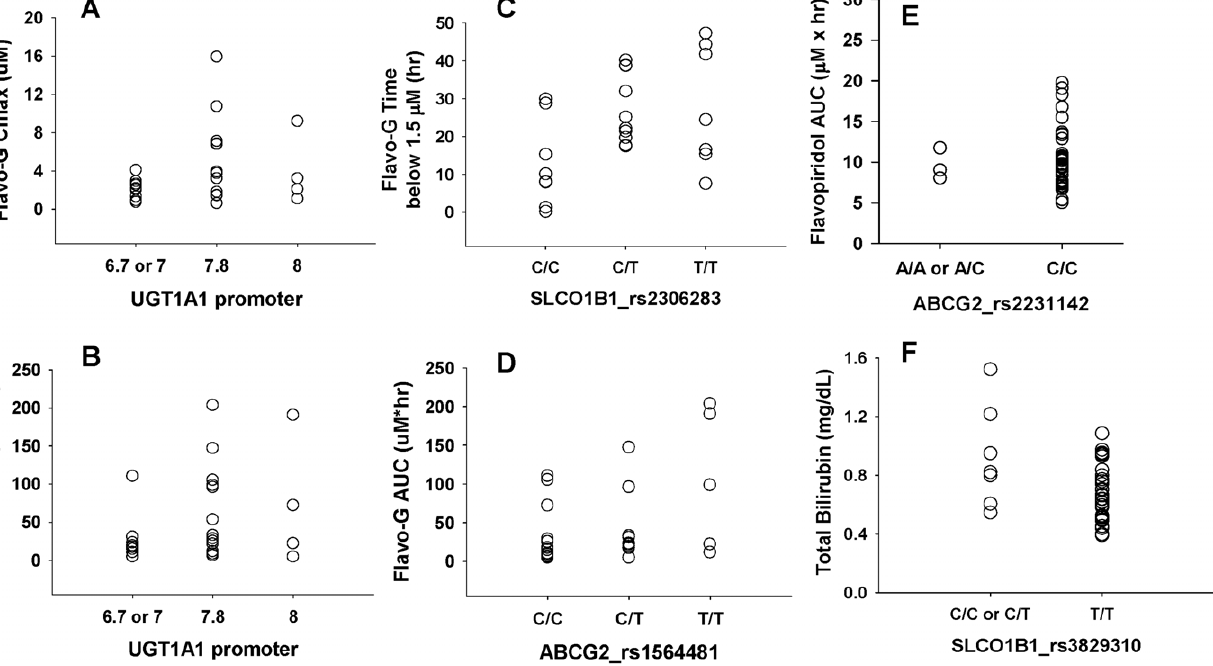
Figure 5. Association of PGx, PK and bilirubin from the phase I dataset. Flavo-G PK parameter estimates from 27 patients were evaluated for relationships with PGx. Fewer TA repeats in the UGT1A1 promoter were weakly associated with lower flavo-G Cmax (Panel A) and AUC (Panel B). For SLCO1B1, the rs2306283 SNP correlated with flavo-G plasma concentrations (the total time flavo-G plasma concentrations were below 1.5 m M, p=.019; Panel C, one outlier removed). For ABCG2, the rs1564481 SNP was associated with flavo-G AUC (p=.050; Panel D) and the rs2231142 SNP was associated with flavopiridol AUC (p=0.08, Panel E). The SLCO1B1 rs3829310 minor C allele was associated with higher baseline total bilirubin (p=.011; Panel F). For plots A and B, the x-axis indicates the number of promoter TA repeats for both gene copies (6.7=6 and 7 TA repeats; 7=7 TA repeats for each gene copy; 7.8=7 and 8 TA repeats; 8=8 TA repeats for each gene copy). doi:10.1371/journal.pone.0013792.g005 PLoS ONE |